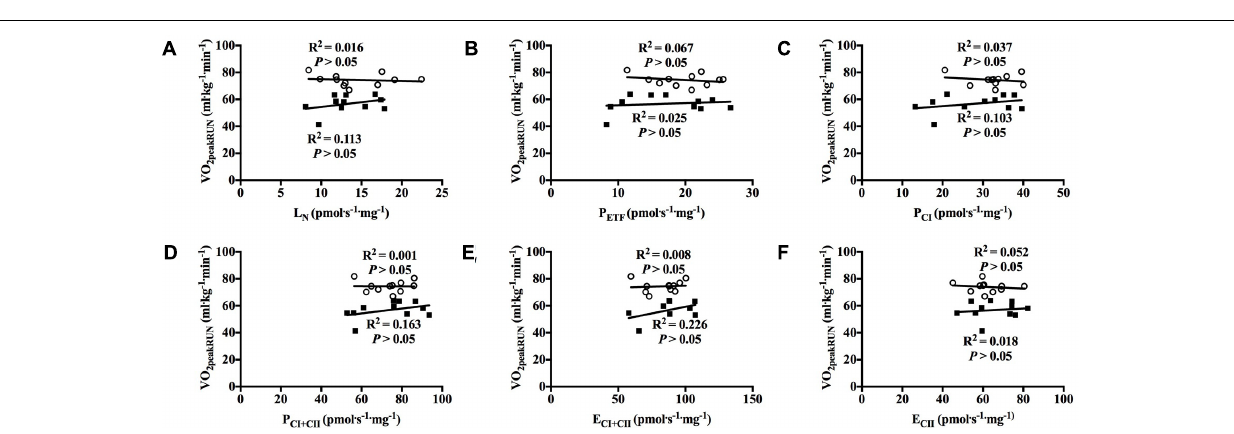
FIGURE 6 | Correlation between peak oxygen uptake (VO 2peak ) in running and respiratory flux for M. vastus lateralis with both groups individually. (A) leak respiration in absence of adenylates (L N ), (B) fatty acid oxidative capacity (P ETF ), (C) complex I respiration (P CI ), (D) complex I and complex II respiration combined (P CI + CII ), (E) electron transfer system capacity (E CI + CII ) and (F) electron transfer system capacity of complex II alone (E CII ). (cid:4) = CON, (cid:13) = XC